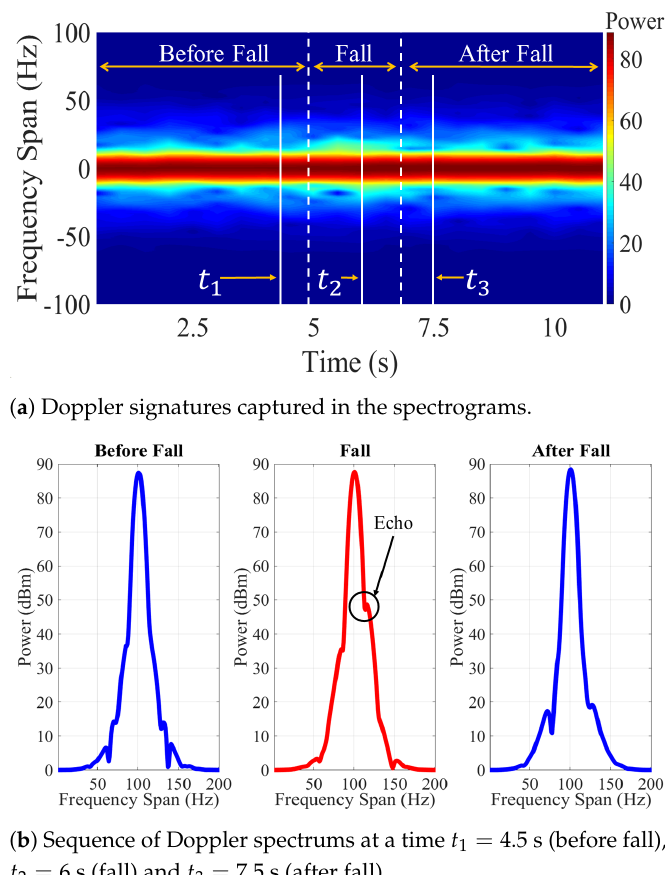
Figure 8. Experimental results using VV scenario setup: ( a ) spectrogram, ( b ) sequence of